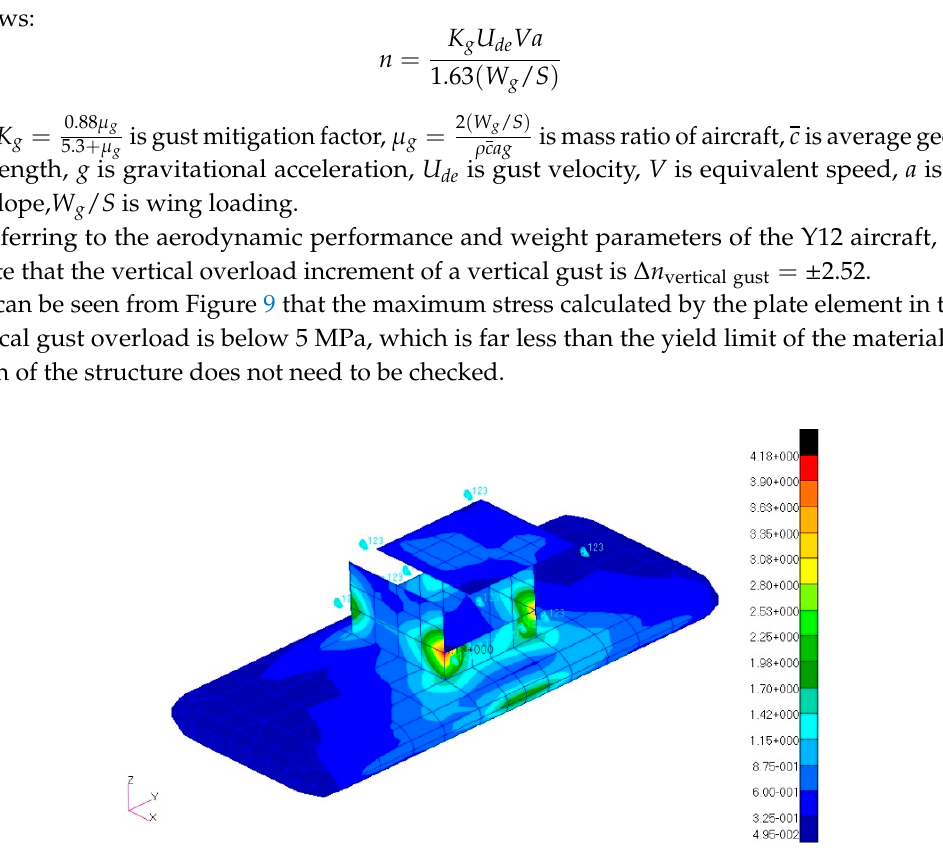
Figure 9. Cloud chart of plate element calculation stress in the case of vertical gust overload.